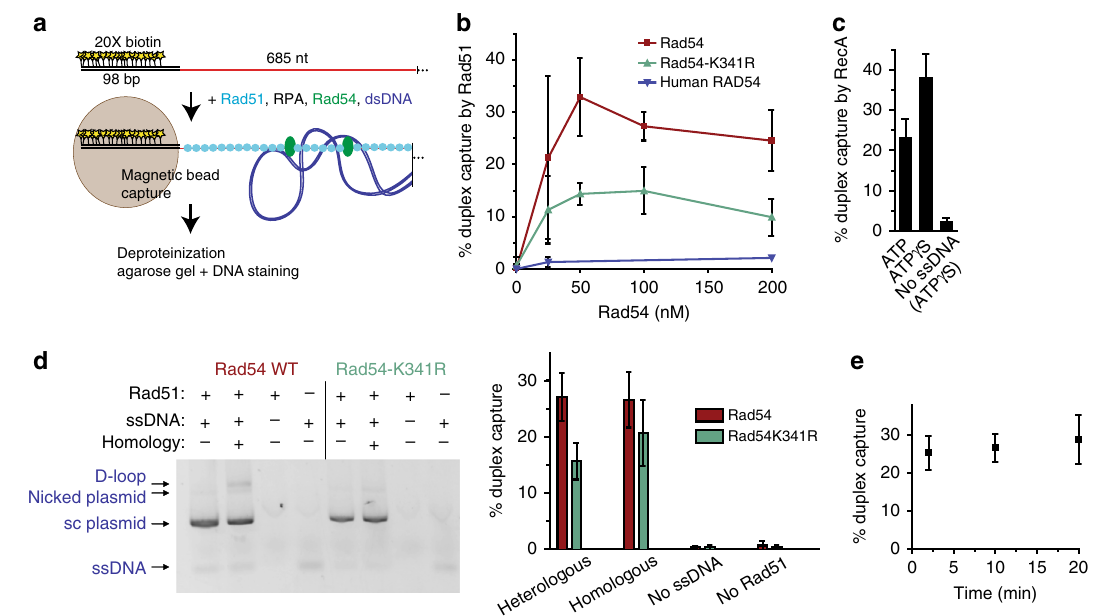
Fig. 5 Duplex capture by Rad51 fi laments is dependent on Rad54. a Duplex capture assay. Proteins were incubated at 30 °C, and the order of addition was 10 min Rad51 (260 nM), 9 min RPA (27 nM), 1 min Rad54 (100 nM or as indicated), 10 min 3 kb supercoiled plasmid DNA (1 nM molecules, heterologous unless noted), 1 min streptavidin-coated magnetic particles before magnetic capture, followed by deproteinization of the isolated bead-bound material for gel electrophoresis/staining to measure captured plasmid DNA. b Titration of Rad54 in the duplex capture reaction. c RecA supported duplex capture. 1 mM ATP or ATP γ S was included in reactions. d Control reactions performed with 100 nM Rad54 wild-type or Rad54K341R protein. Homologous